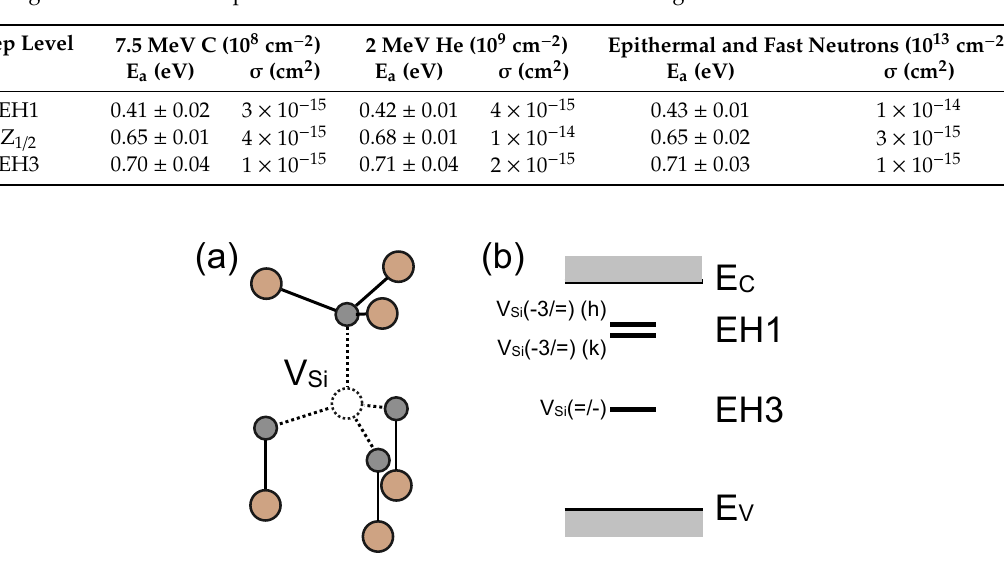
Figure 4. Schematic illustration of ( a ) silicon vacancy and ( b ) energy positions of the attributed deep levels .